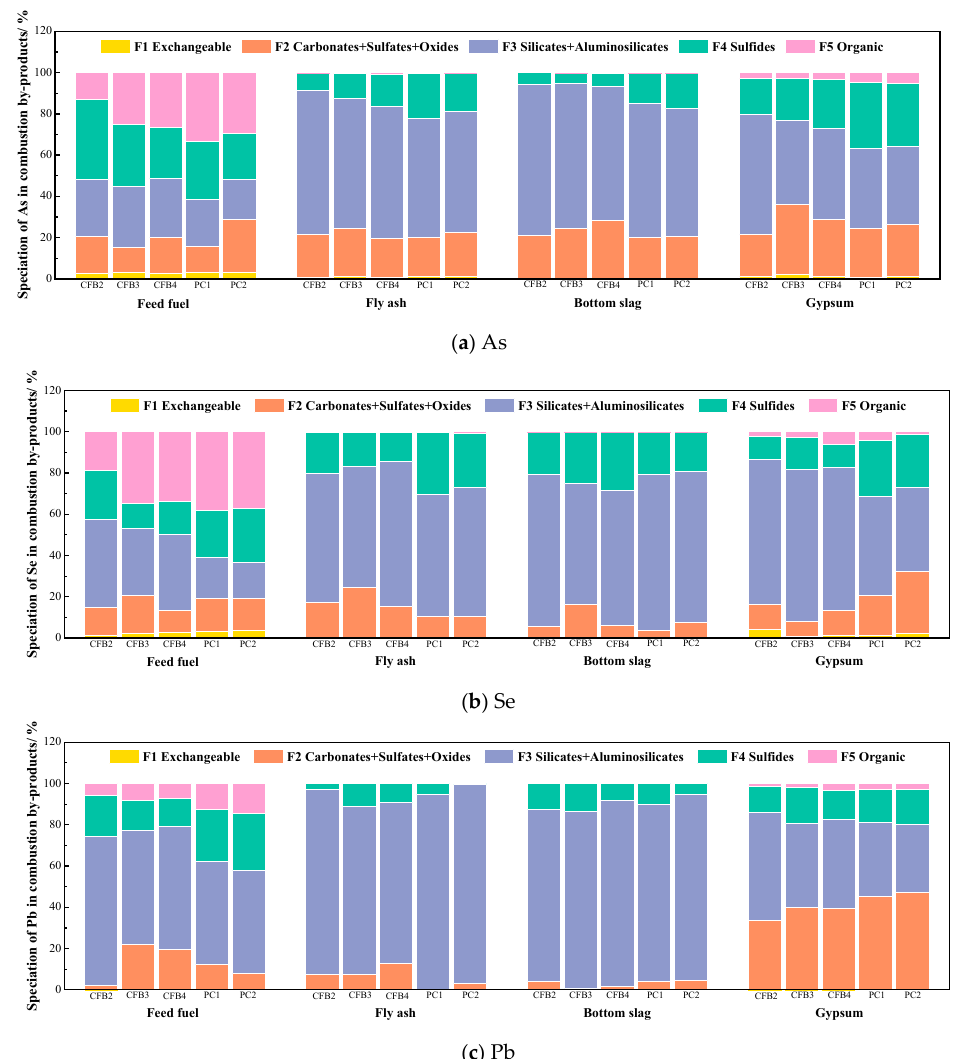
Figure 6. Speciation distribution of As, Se and Pb in feed coal and combustion by-products of coal-fired power units.